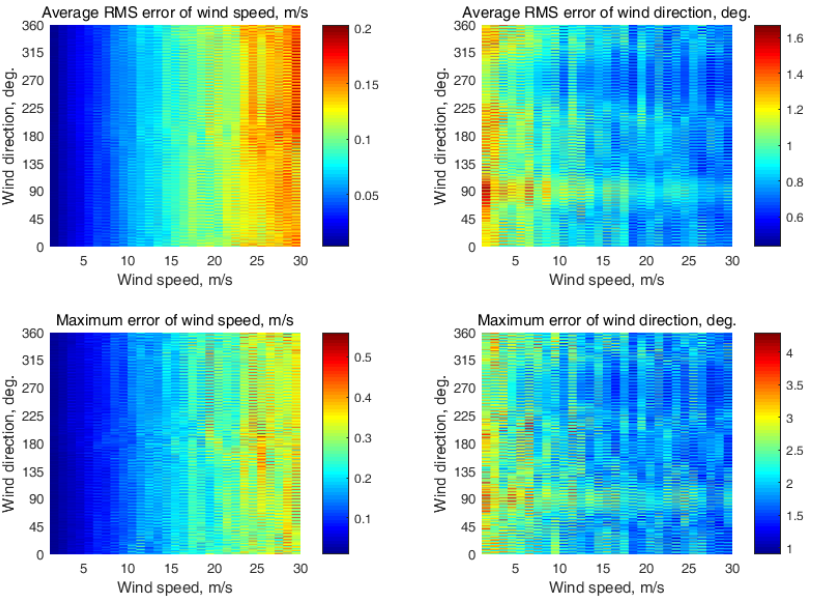
Figure A15. Semicircular wind retrieval results at the (30°, 35°, 40°) incidence angle combination.